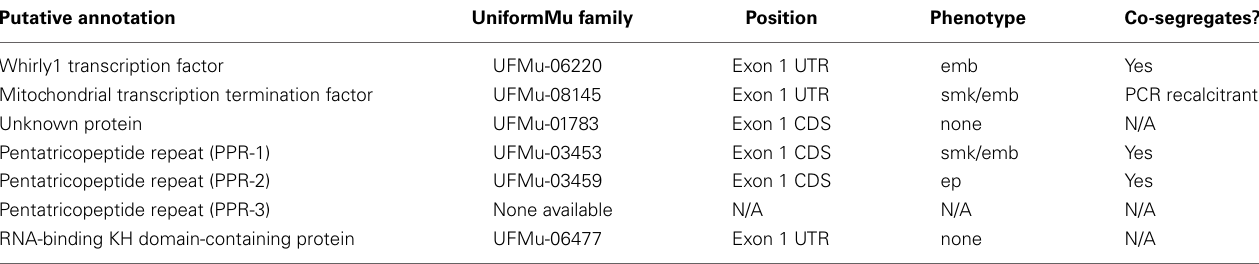
Table 4 | Genetic analyses of additional alleles from